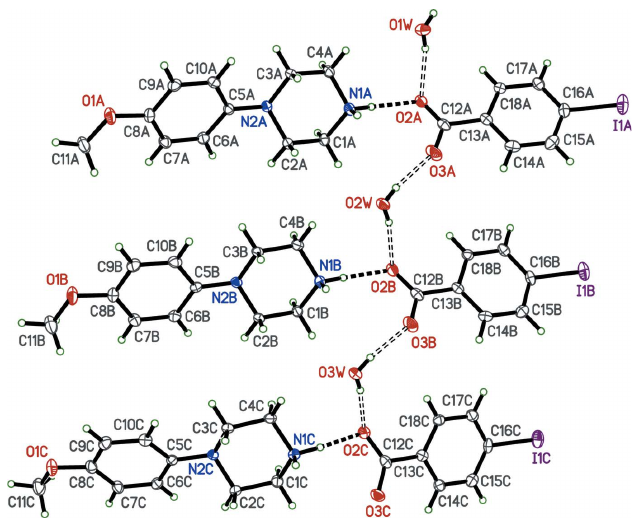
Figure 3 An ellipsoid plot (50% probability) of III . The solid dashed lines denote N—H (cid:2)(cid:2)(cid:2) O hydrogen bonds, while the open dashed lines represent O— H (cid:2)(cid:2)(cid:2) O hydrogen bonds. Hydrogen atoms are drawn as arbitrary circles.